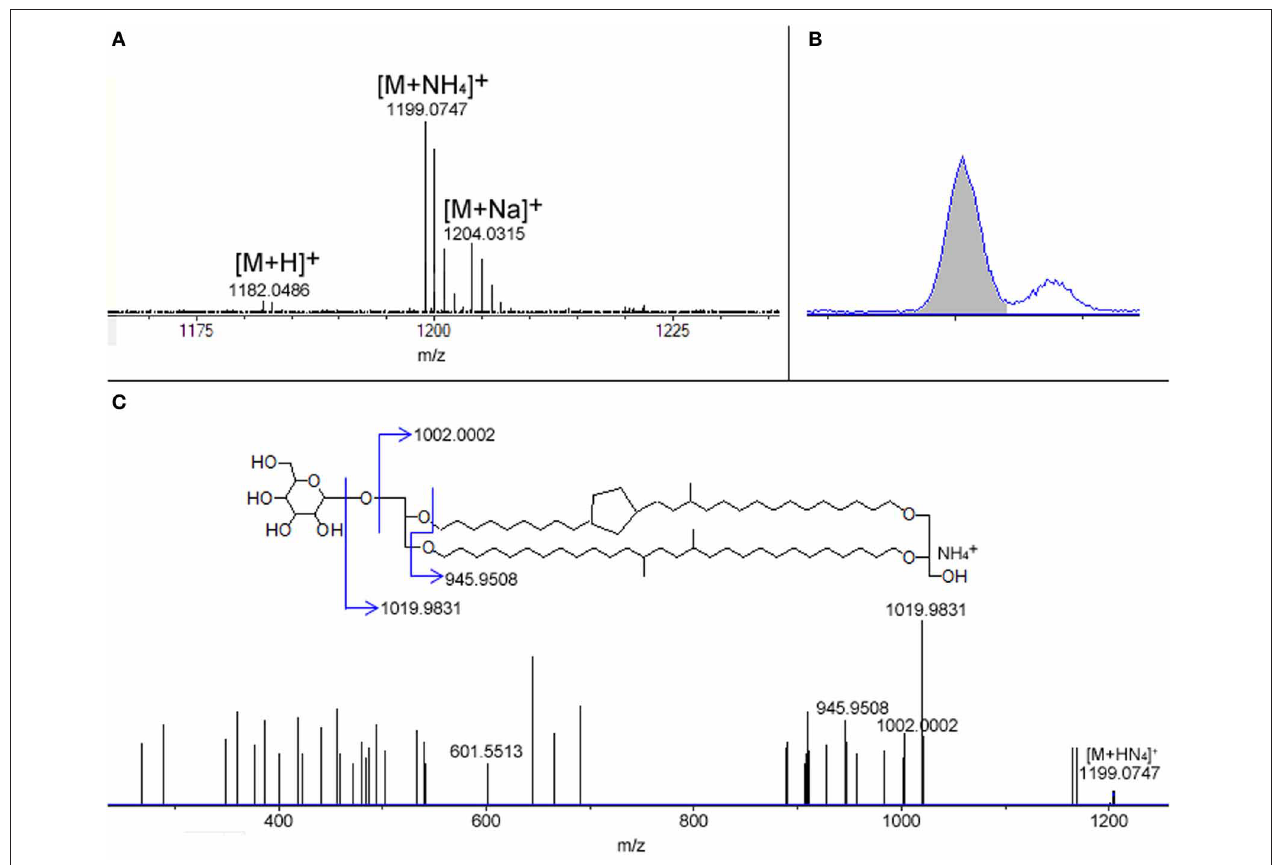
FIGURE A2 | Occurrence of monoglycosidic bGDGT Ib (1G-bGDGT Ib) at site C in Figure 1, which was determined by RP-ESI-MS n . (A) The measured accurate masses of [M+H] + , [M+NH 4 ] + , [M+Na] + adduct ions.